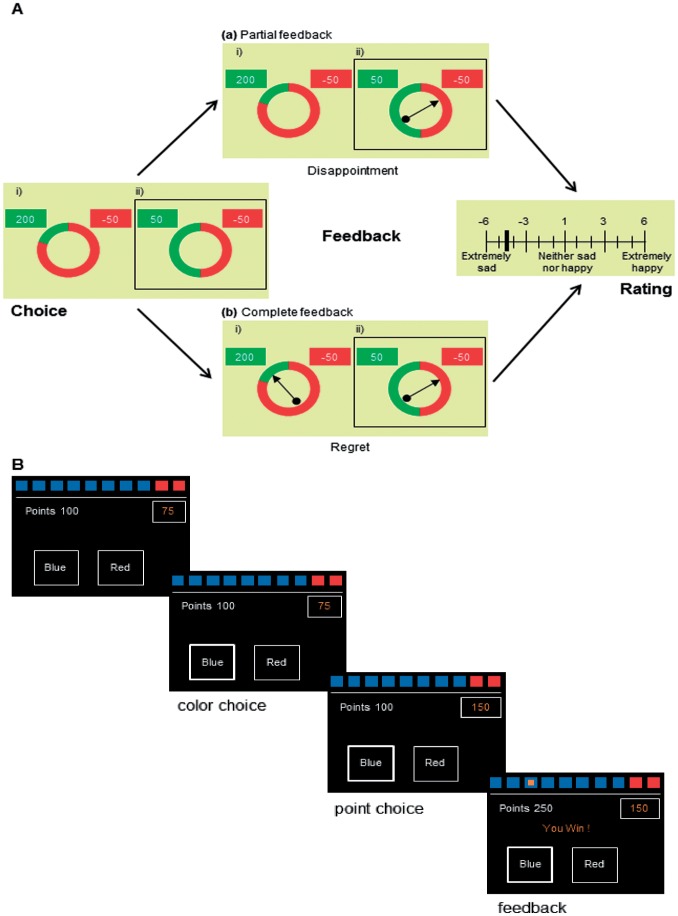
Description of the two gambling tasks.A) Wheel of Fortune (WOF): the subject (with SCR recorded) has to choose between two possible lotteries with different risk and earning possibilities. The subject was asked to choose one of the two wheels by pressing a left or a right button (choice period). A spinning arrow then appeared at the center of the wheel, spins for a variable duration (wait period), and stopped revealing the outcome(s) (feedback period). In the partial feedback condition (30 trials) the subject does not know the outcome of the other lottery; in the complete feedback condition (30 trials) both outcomes are presented. At the end of each trial, subjects had to indicate their affective state using a rating scale. B) Cambridge gambling task (CGT): the subject has to bet points on a choice associated with a given level of risk. Trials are run in blocks (two sets of four blocks), each containing nine trials. A row of ten boxes (red or blue, with a ratio varying across trials) is presented at the top of the screen. Participants are told that a yellow token was hidden in one of the boxes. They then have to guess whether it is in a red or blue box (color). Then they decide how many of their points they wanted to gamble on their choice (point choice) by pressing when they choose: available bets (5, 25, 75, 95 and total) are presented on the right of the screen in a ascending or descending sequence. Then feedback is given about gain or loss and total ongoing fortune (left).